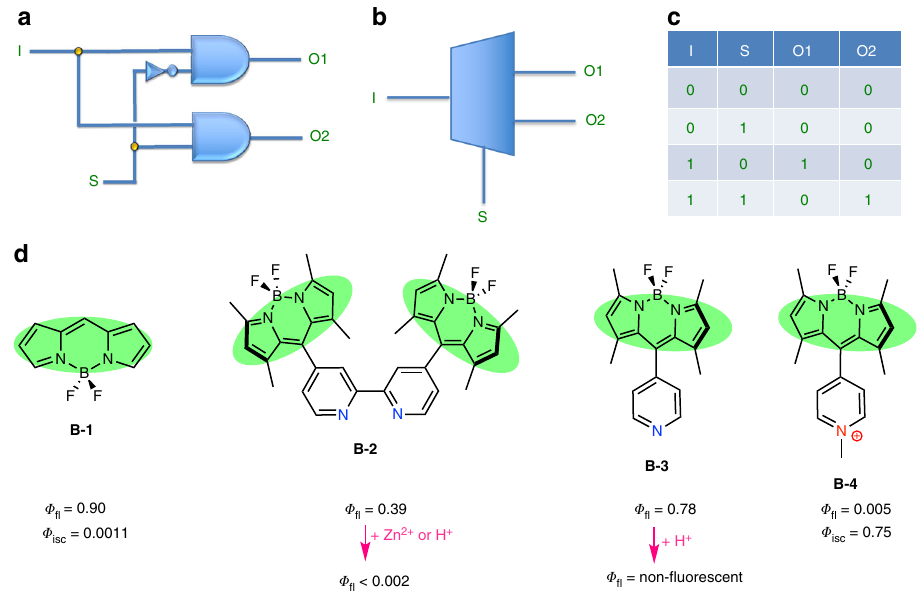
Fig. 1 DEMUX combinatorial circuit and structures of relevant Bodipy compounds. a DEMUX circuit with standard logic gate symbols. b Isosceles trapezoid is a common symbol for the MUX/DEMUX circuits. I is the data input, S is the select or address input, and O1 and O2 are two different outputs. c The truth table for a 1:2 DEMUX circuit is on the right. d Structures of the parent Bodipy compound B-1 31 , and meso -pyridyl 22 /bipyridyl 20 substituted derivatives, together with their respective fl uorescence and intersystem crossing quantum ef fi ciencies are demonstrated. Protonation of both B-2 and B-3 result in the pyridinium cation, which switches on the intramolecular charge transfer process. Coordination of Zn 2 + ions or quaternization at the pyridine nitrogen ( B-4 ) results in the same photophysical